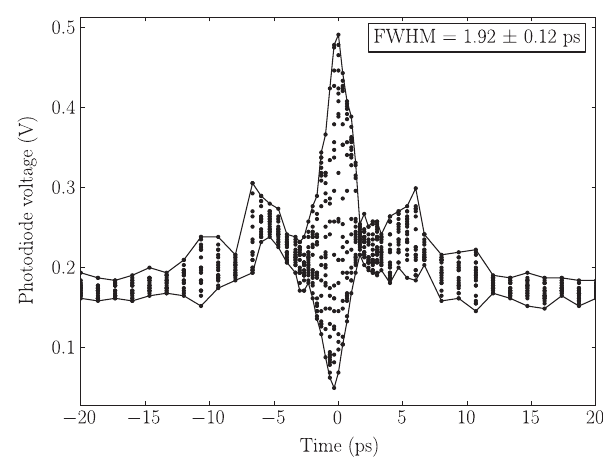
FIG. 13. Autocorrelation of the first pulse in the amplified burst with an energy of 165 . 8 (cid:1) 0 . 4 μ J with the envelope